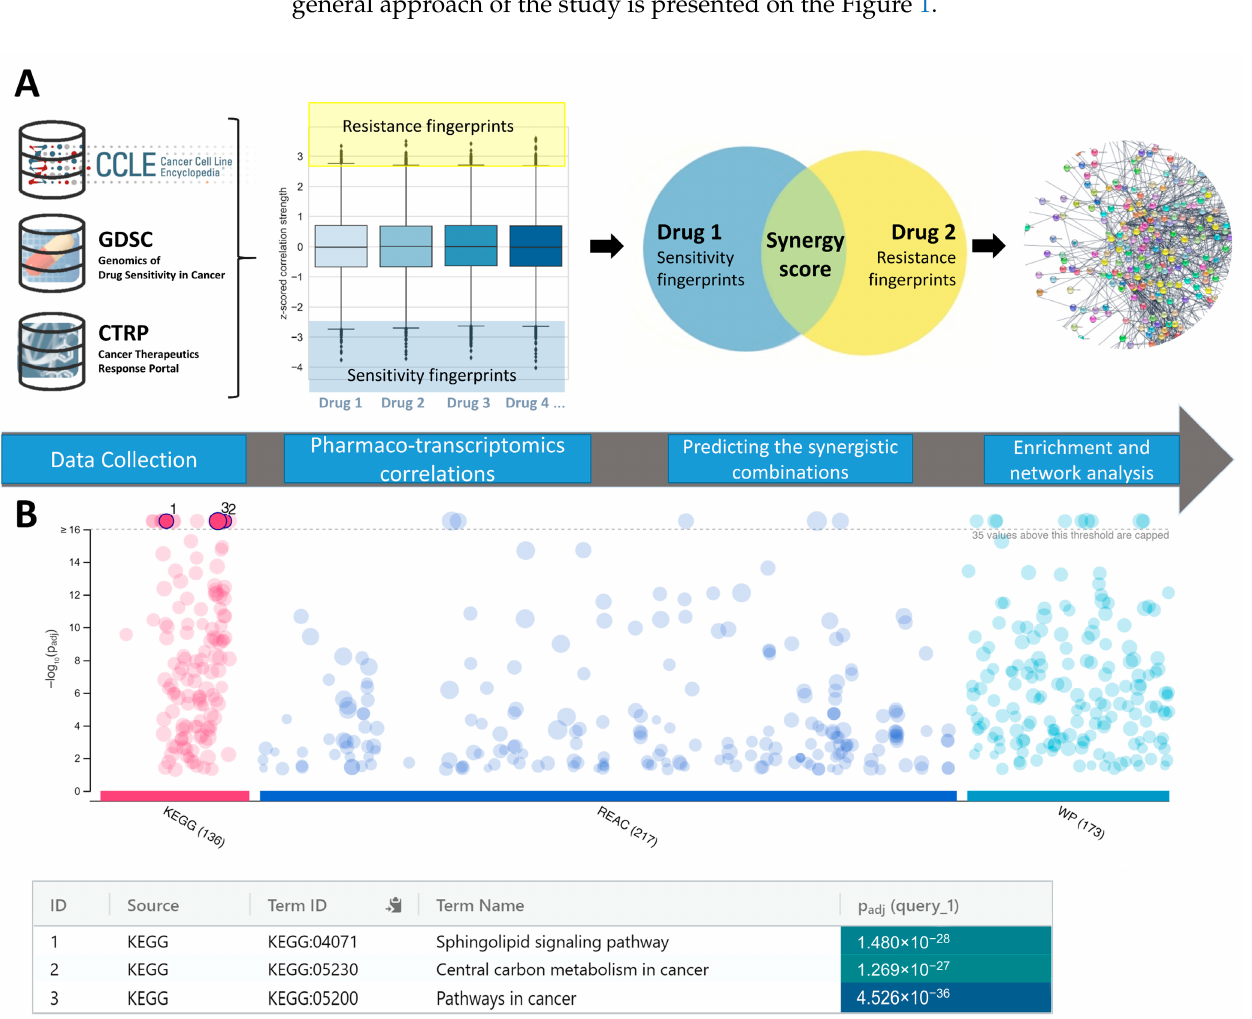
Figure 1. Overall design of the study and results of enrichment analysis. ( A ) The preview of the approach used to identify synergistic interactors of HDACi; ( B ) Results of the pathway enrich- ment analysis indicated sphingolipid signaling pathway as a novel target for synergistic treatment of